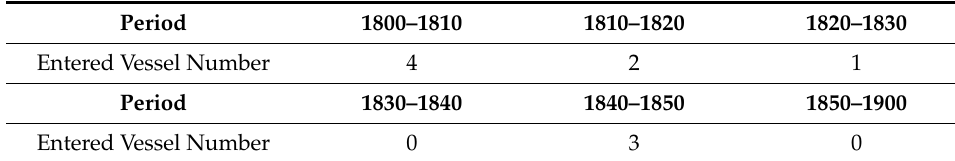
Table 2. The Number of Entered Vessels